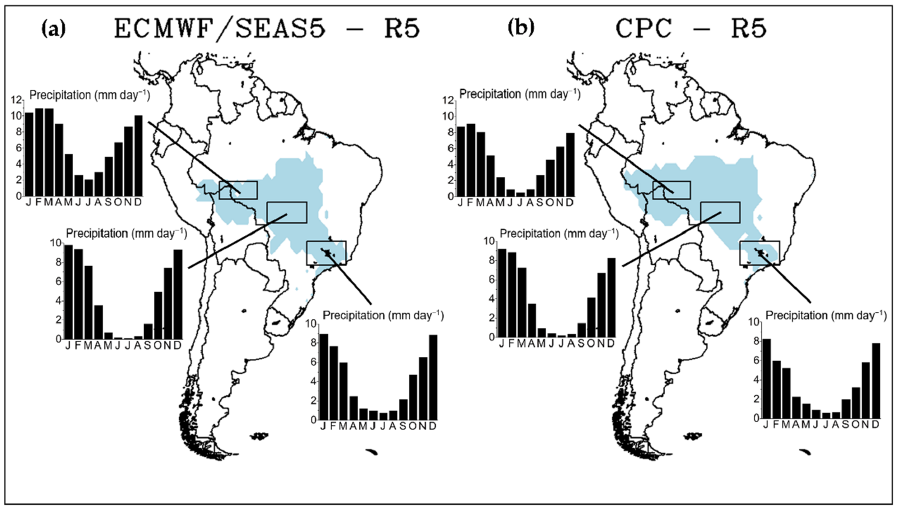
Figure 10. Similar to Figure 6, except for Region 5